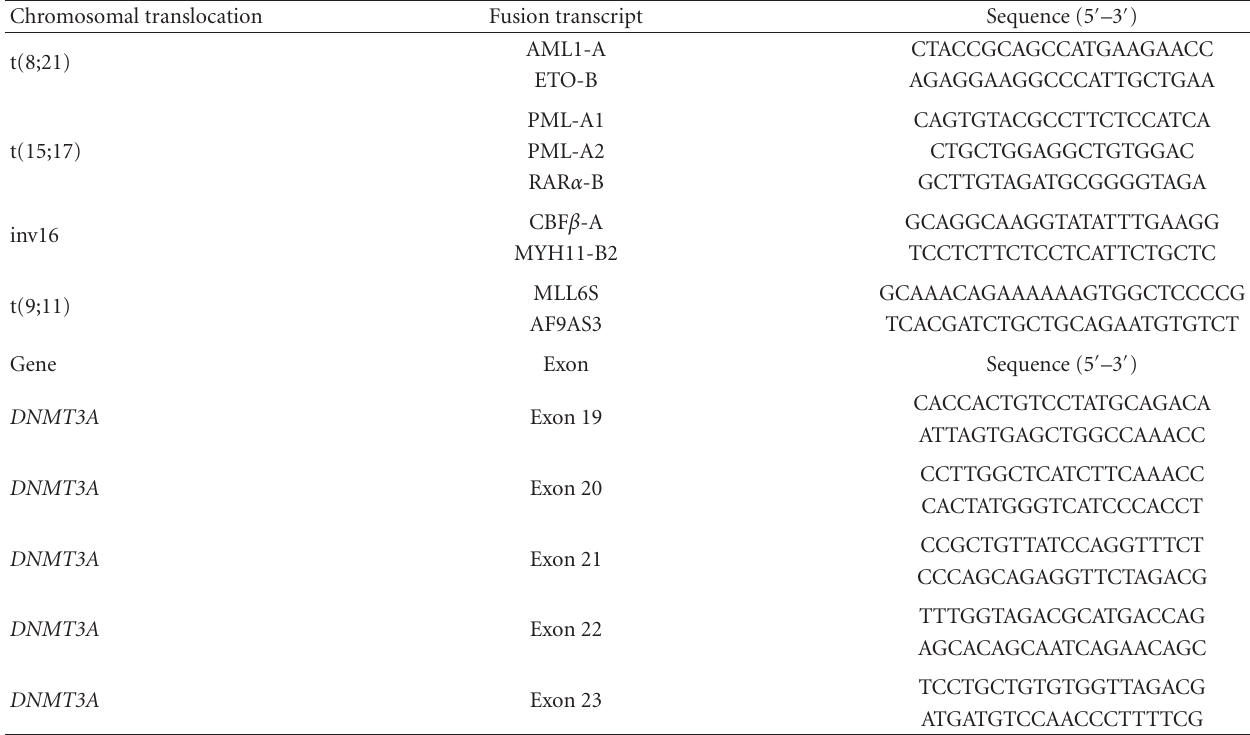
Table 2: Primer sequences for genes of